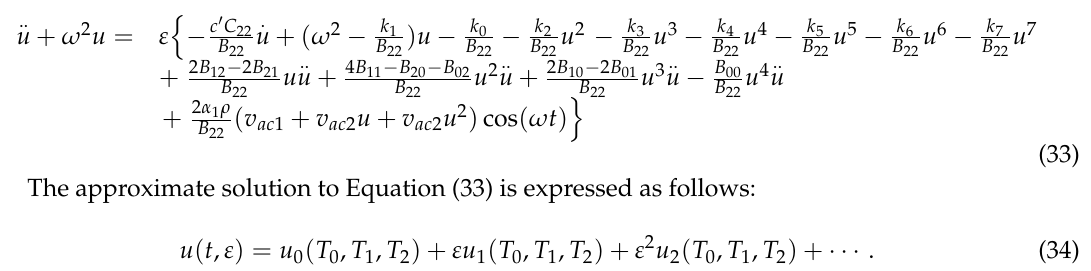
Figure 13. Influence of the section parameters on system vibration characteristics under linear vibration. ( a ) Influence of the cross-section parameters on the equivalent natural frequencies under linear vibration. ( b ) Influence of the section parameters on vibration amplitude under linear vibration.